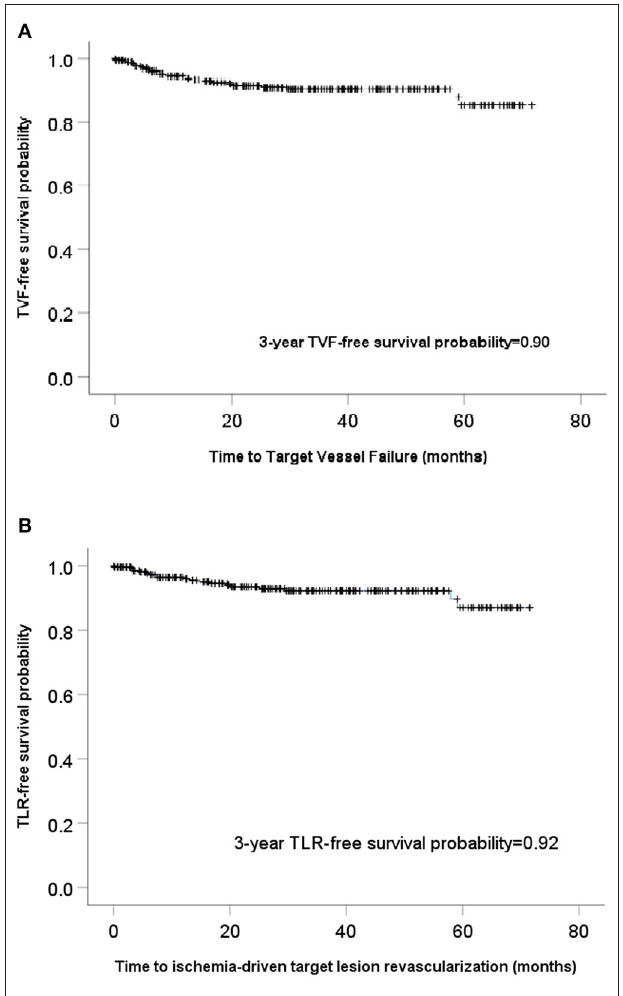
FIGURE 4 | Kaplan–Meier curves showed the overall target vessel failure (TVF) (A) and clinically-driven target lesion revascularization (TLR)-free survival (B) .